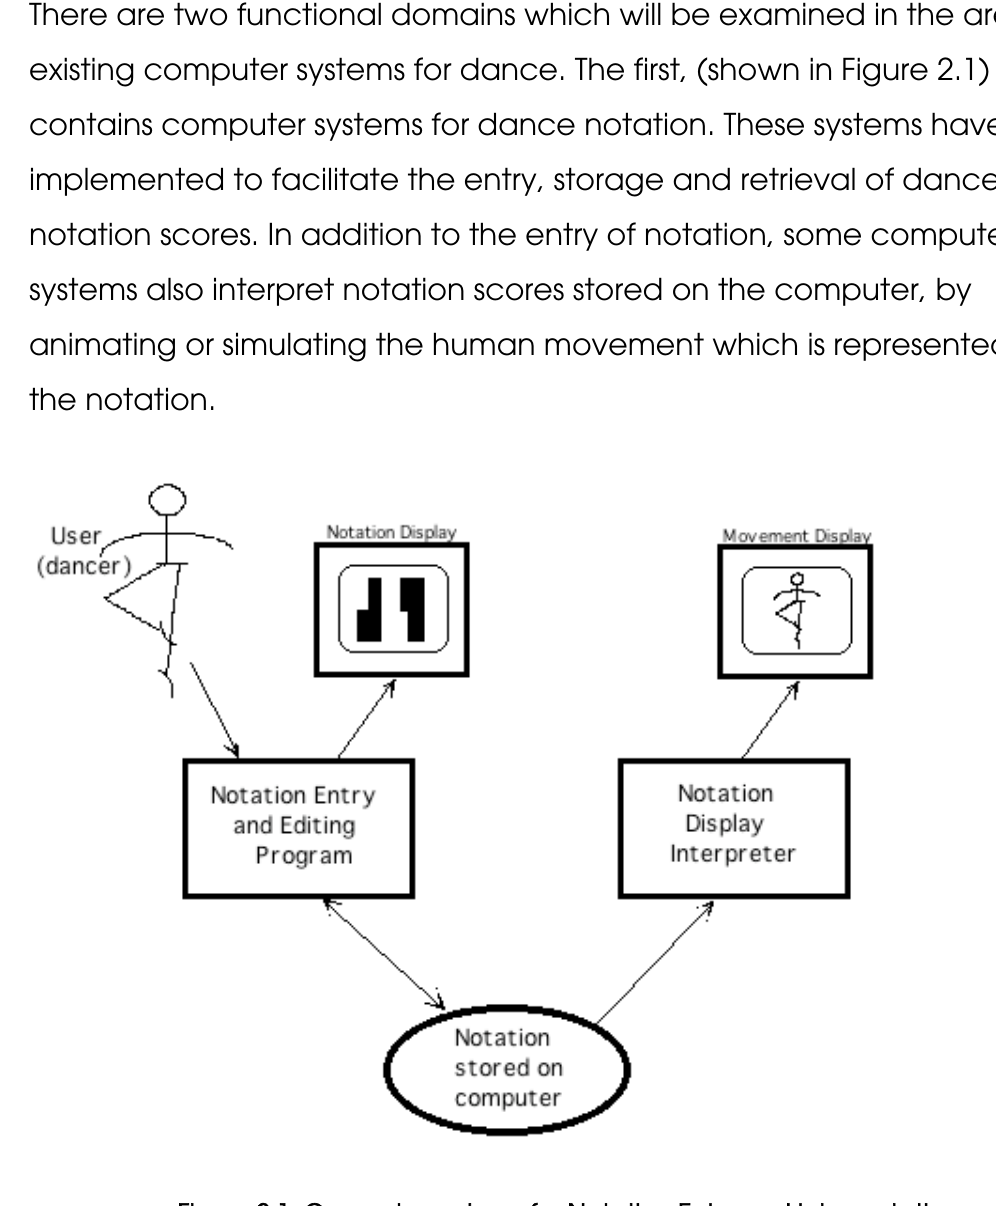
Figure 2.1. Computer systems for Notation Entry and